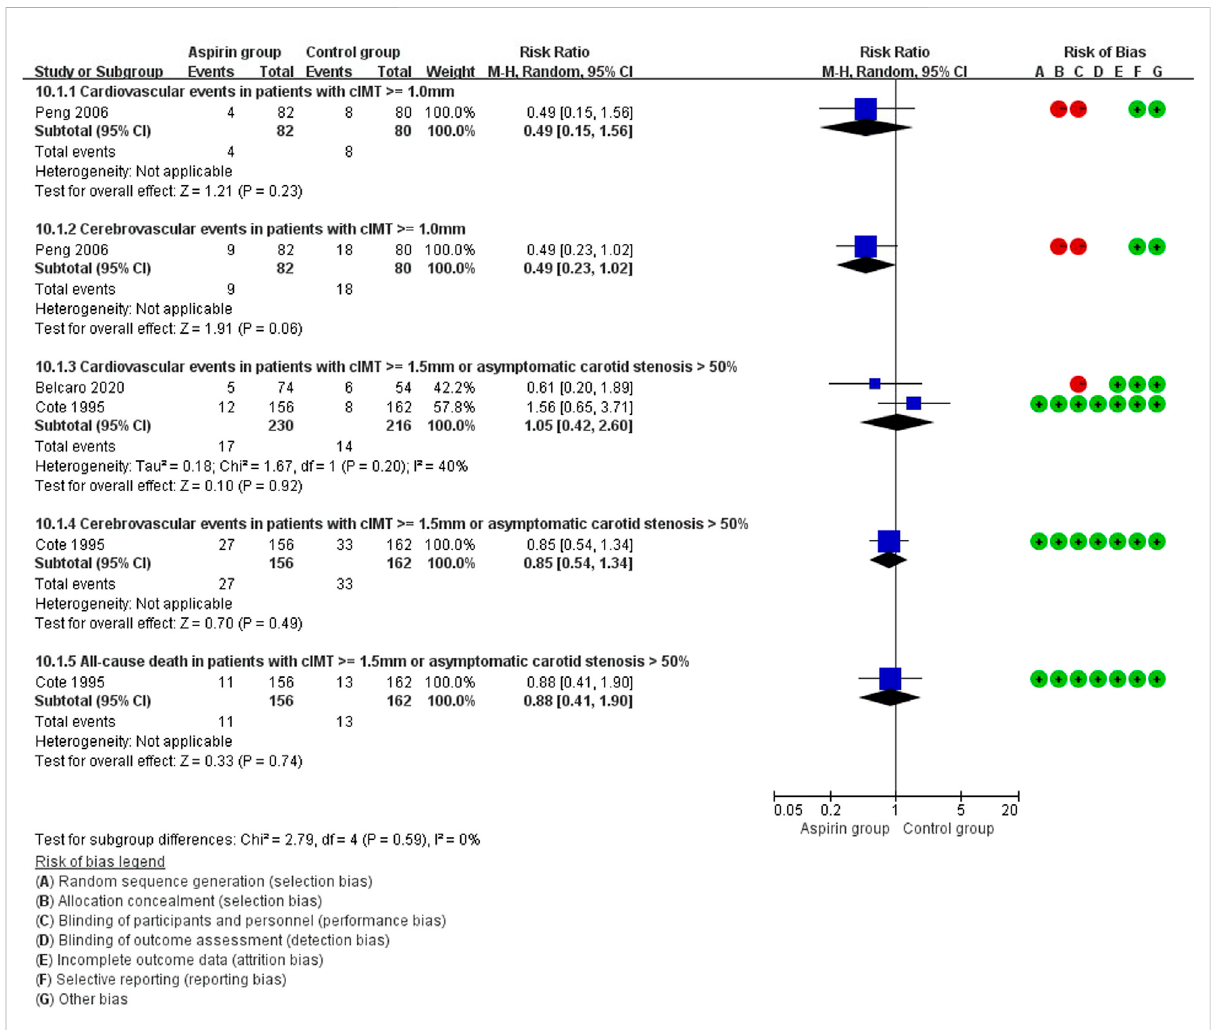
FIGURE 10 Forest plot of outcome events in patients with different carotid intima-media thickness (cIMT) or carotid